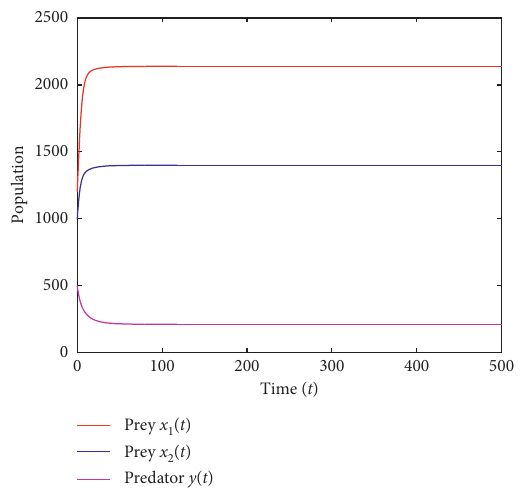
Figure 3: The trajectories of model (5) with σ 2 figure